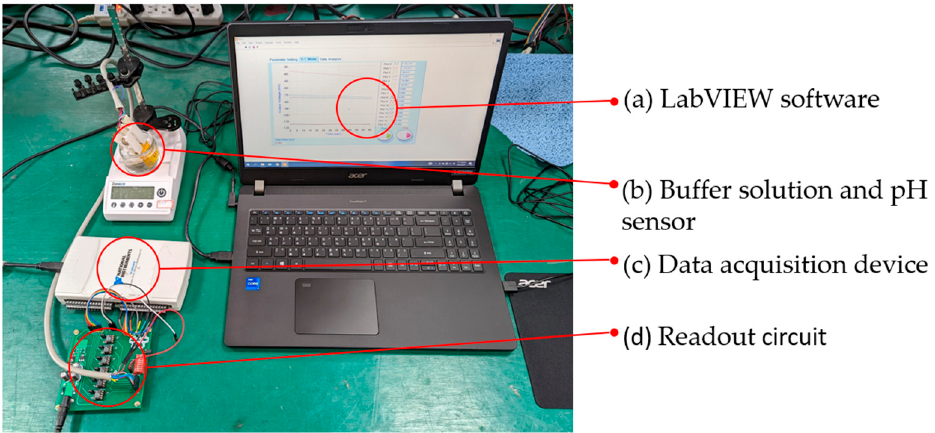
Figure 2. The voltage–time (V-T) measurement system.